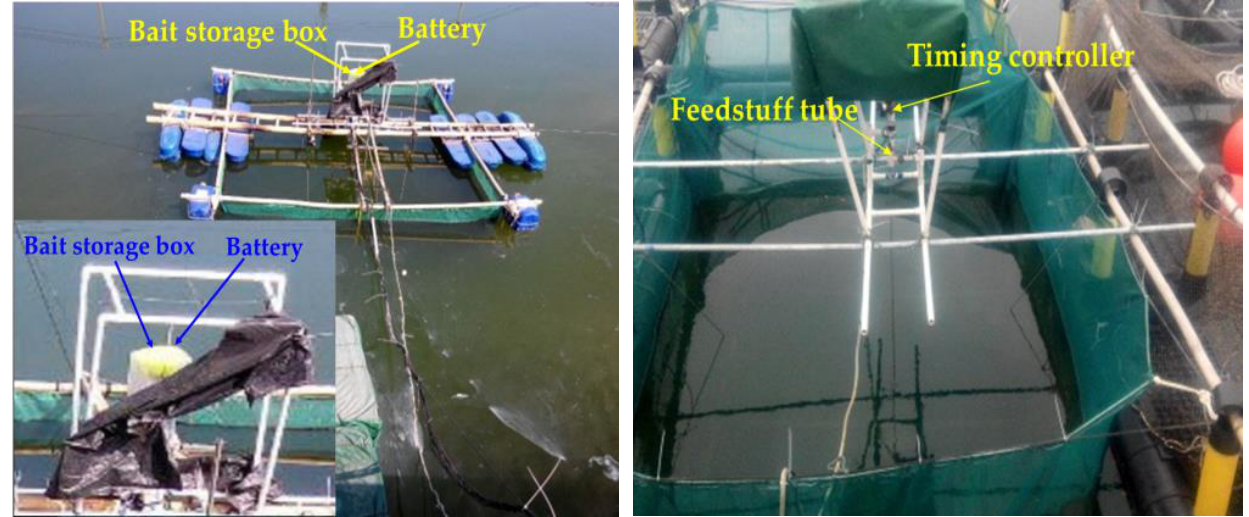
Figure 4. Images of the acoustic conditioning taming experimental setup in the open water.